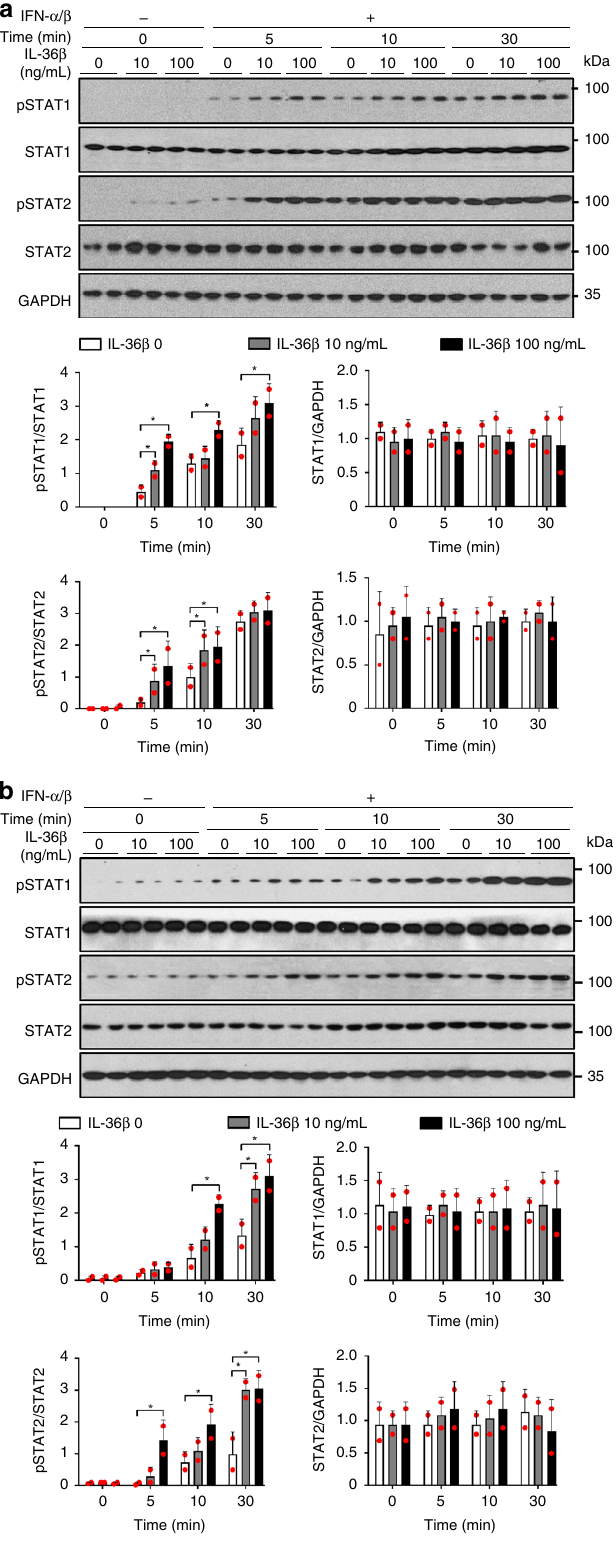
gene duplication of IL1B to counteract microbial immune evasion strategies that prevent activation of IL-1 β by utilizing alternative mechanisms of activation and extracellular release 2 . The here identi fi ed enhancement of type I IFN (Figs. 9 and 10c) by IL-36 and IL-1 represents a complementary approach to overcoming